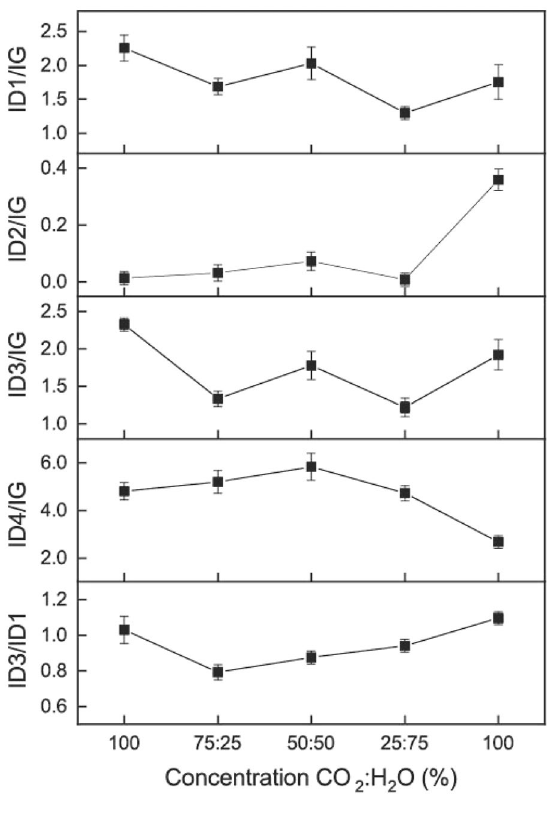
Figure 5. Ratios between major band intensities of activated chars.